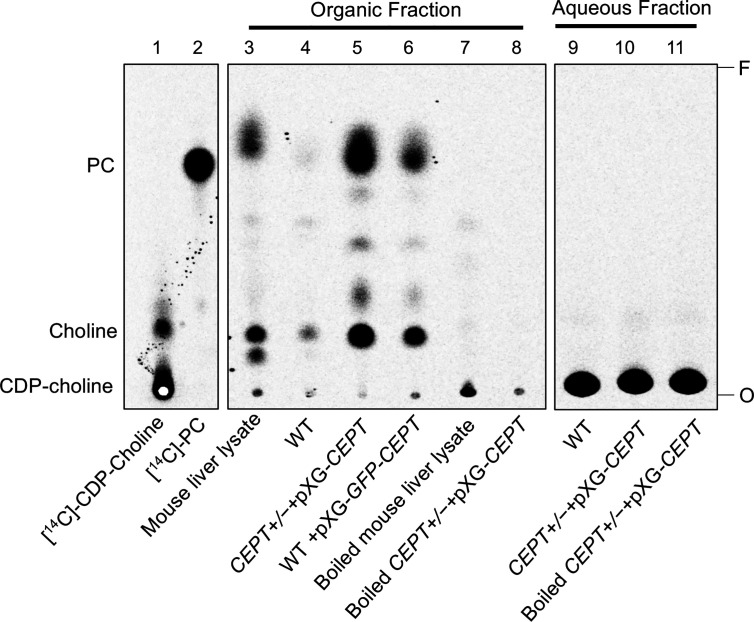
CEPT is responsible for the synthesis of PC from CDP-choline and DAG. Mouse liver lysate or promastigote lysate were incubated with [14C]-CDP-choline and DAG followed by extraction with 1-butanol and TLC analysis as described in Materials and Methods. Lane 1: [14C]-CDP-choline. Lane 2: [14C]-1,2-diarachidonyl PC. Lanes 3–8: Organic fractions after 1-butanol extraction. Lanes 9–11: aqueous fractions after 1-butanol extraction. O: origin. F: Solvent front. This assay was repeated three times and results from one representative experiment were shown here.